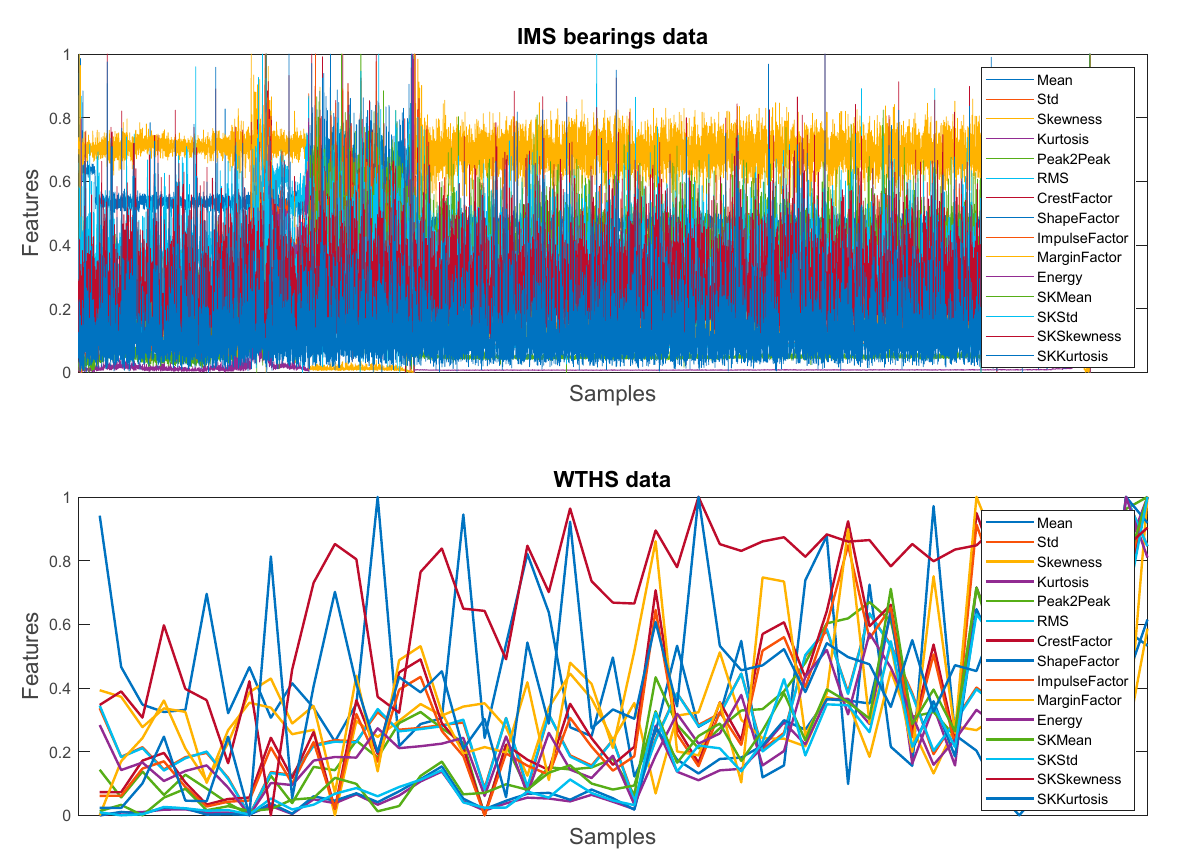
Figure 6. Final prepared versions of the studied datasets.